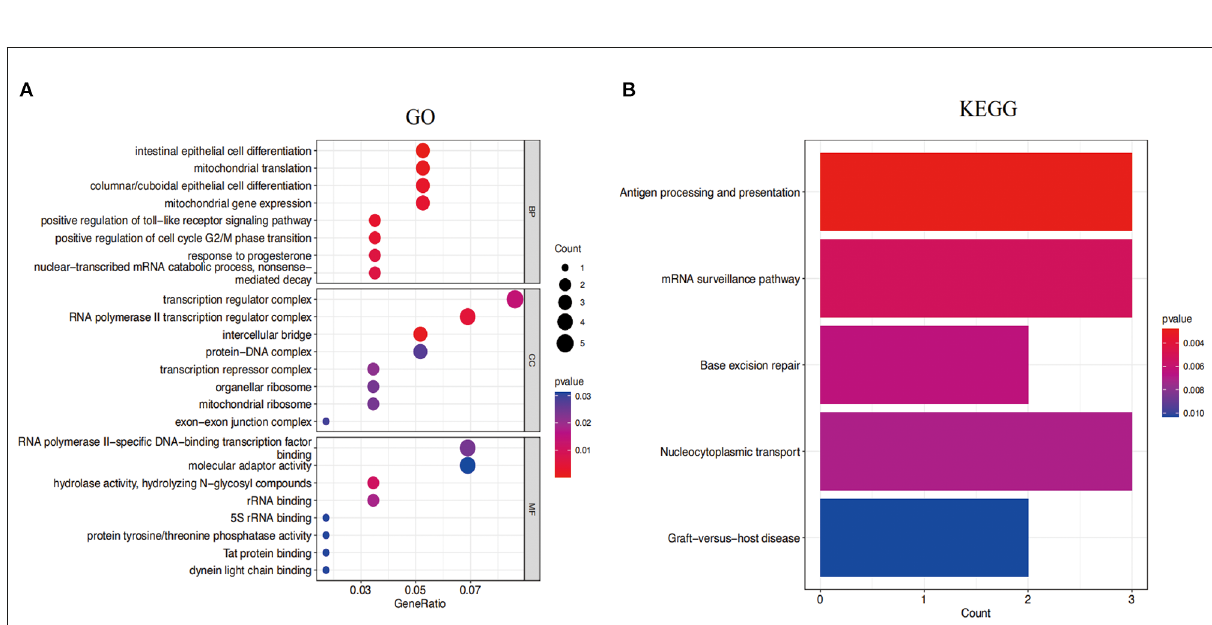
FIGURE5 (A) Gene Ontology (GO) enrichment results for the top eight common genes. (B) Kyoto Encyclopedia of Genes and Genomes (KEGG) pathway result of the top eight common genes. P -value < 0.05 was considered significant.